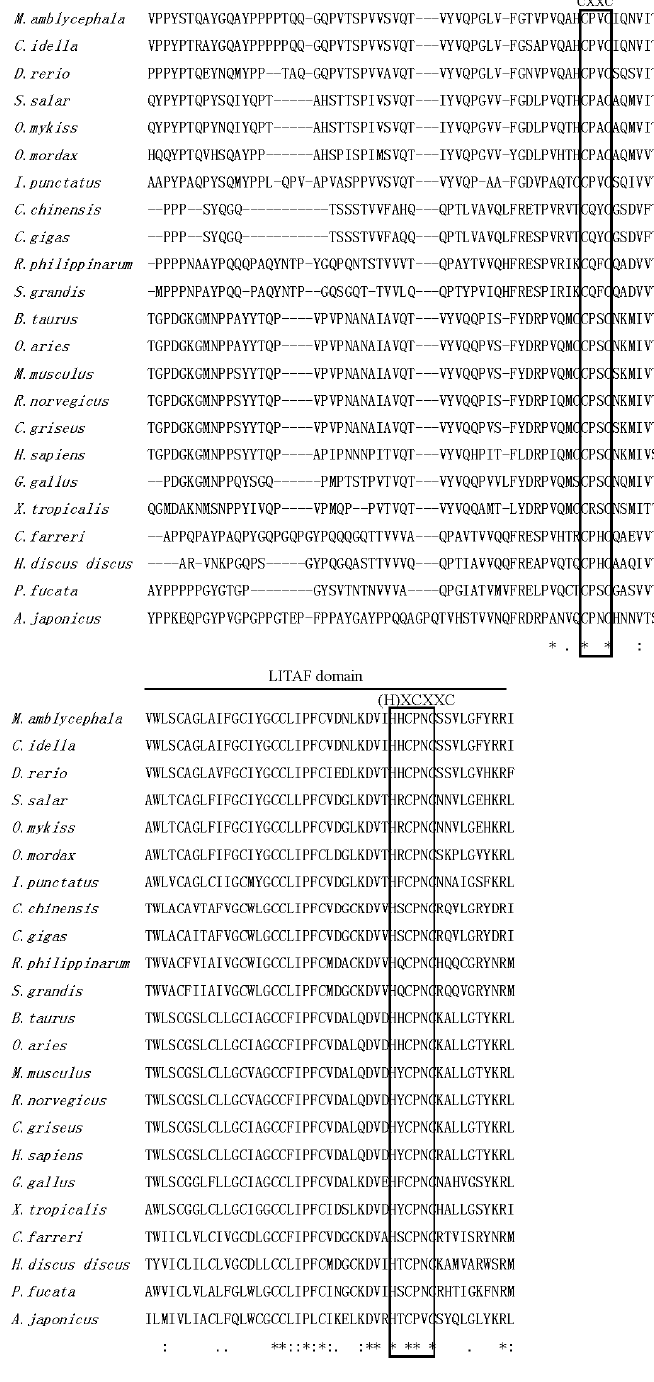
Figure 2. Multiple sequence alignment of LITAFs. The identical, highly conserved, and less conserved amino acid residues are indicated by “*”, “:”, and “.”, respectively. The gaps in the alignment are indicated by “-”. The LITAF domain was labeled above the sequences, and two motifs were indicated with rectangles.